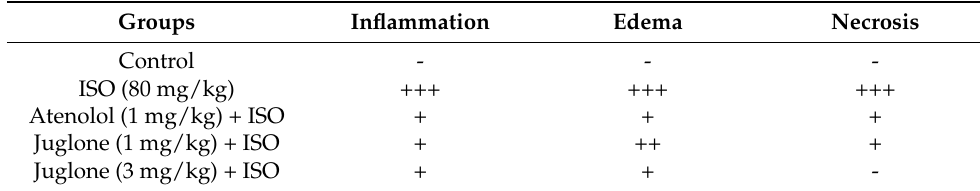
Table 1. Preventive effects of juglone and atenolol on the degree of histological changes in my- ocardium of isoproterenol (ISO)-administered ischemic rats. Groups Inflammation Edema Necrosis Control - -